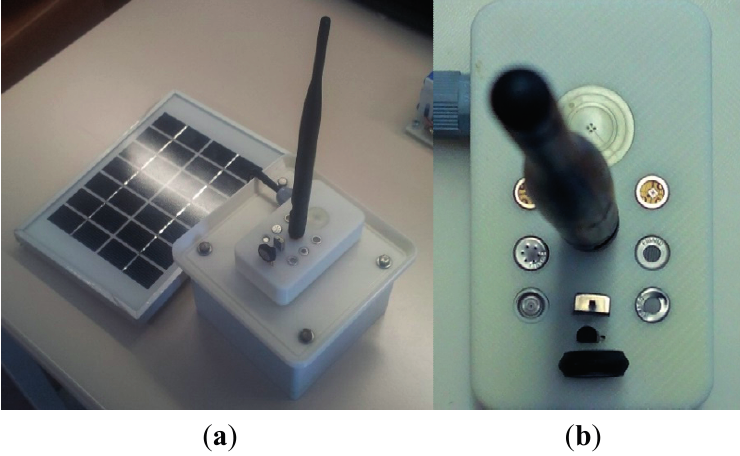
Figure 8. UIS Gas node. ( a ) UIS Gas node; ( b ) Gases module.